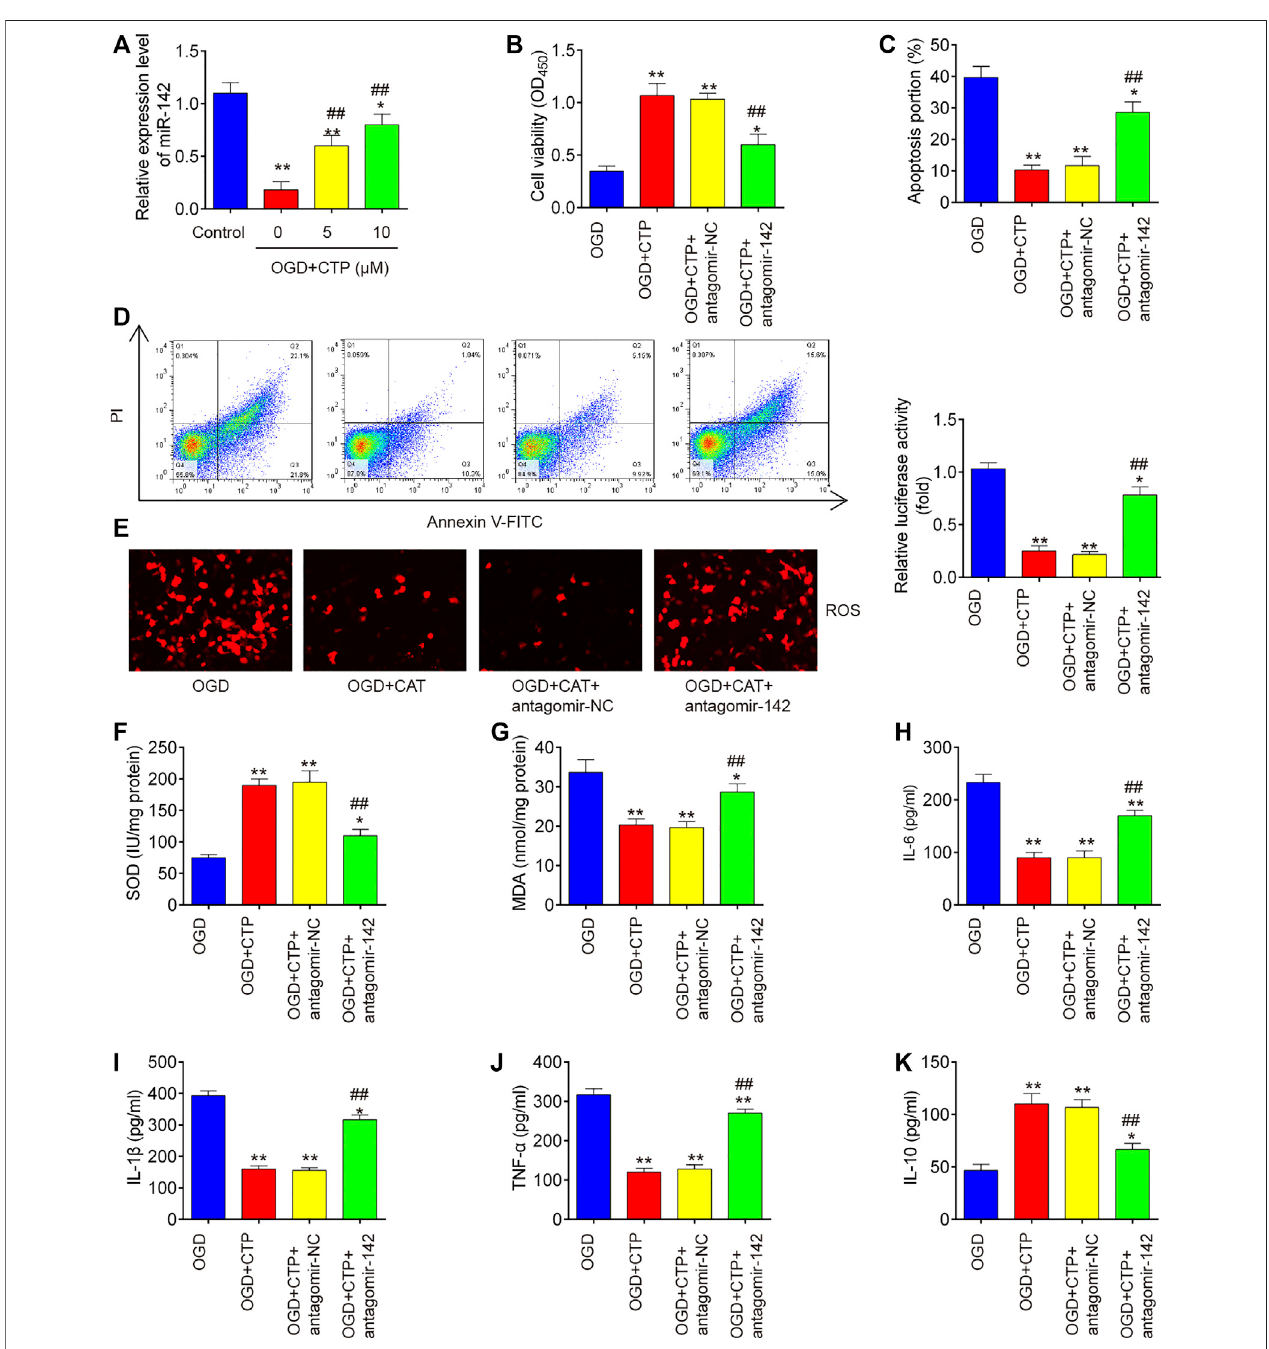
FIGURE 6 | Catalpol improved OGD/R induced neuronal injury by upregulating miR-142 in vitro. BV-2 cells were transfected with antagomiR-142 in the presence with CTP (0, 5 and 10 μ M), following subjected to OGD/R. (A) The expression of miR-142 was determined by qRT-PCR. (B) Cell viability was assessed using CCK-8 assay. (CandD) Apoptosiswasmeasuredusing fl owcytometry. (E) ROSgenerationwascalculatedusing2,7-DCF-DAstainingkit. (FandG) ThecontentsofMDAand SOD were measured by commercial kits. (H – K) The in fl ammatory cytokines including TNF- α , IL-1 β , IL-6 and IL-10, were evaluated by ELISA assays. Data represent the mean ± SD of three independent experiments. * p < 0.05, ** p < 0.01 vs. OGD/R group; ## p < 0.01 vs. OGD/R + CTP group.